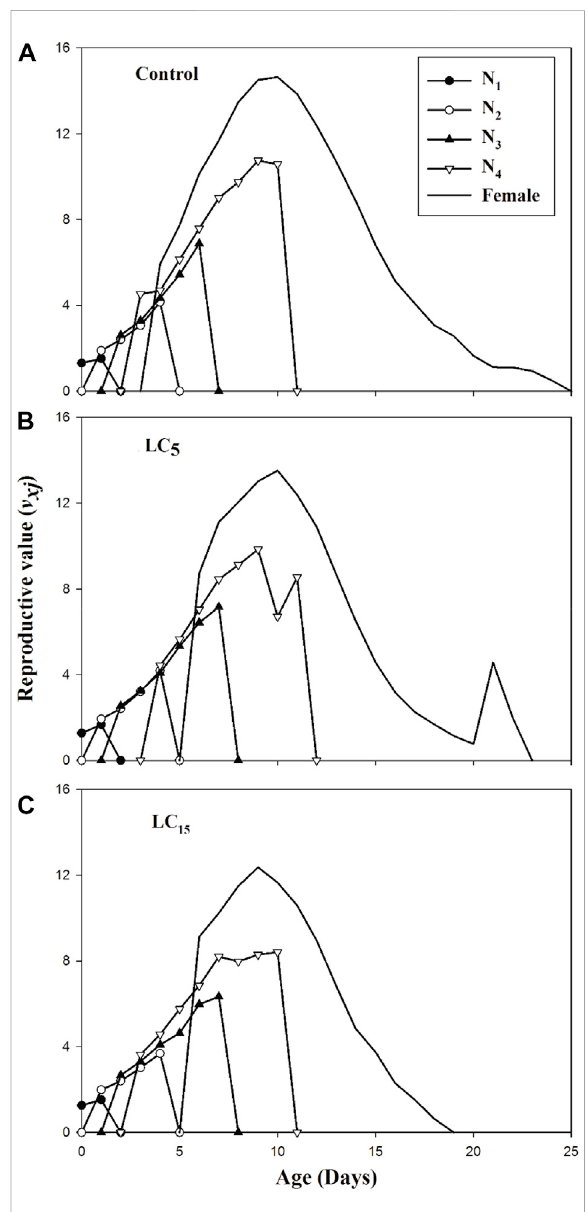
FIGURE 3 (A – C) : Age-Stage speci fi c reproductive value (v xj ) of control group (A) and B. brassicae treated with LC 5 (B) and LC 15 (C) of Spirotetramat in F 1 generation.